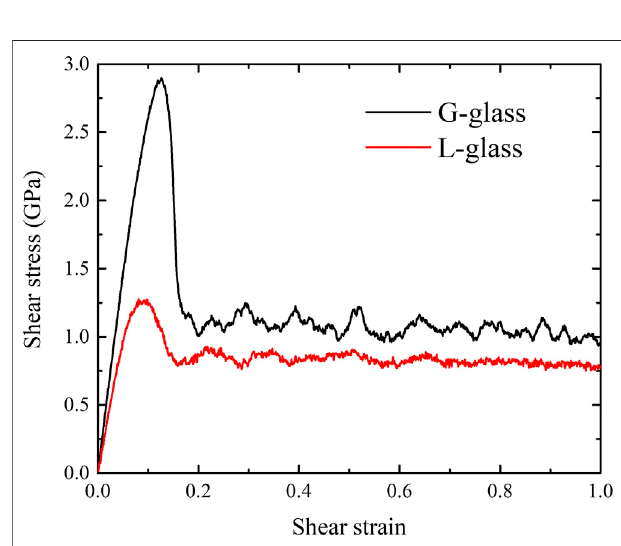
FIGURE3| Theshear-stress-shear-strainrelationshipsofbothG-phase and L-phase under shear deformation at room temperature.